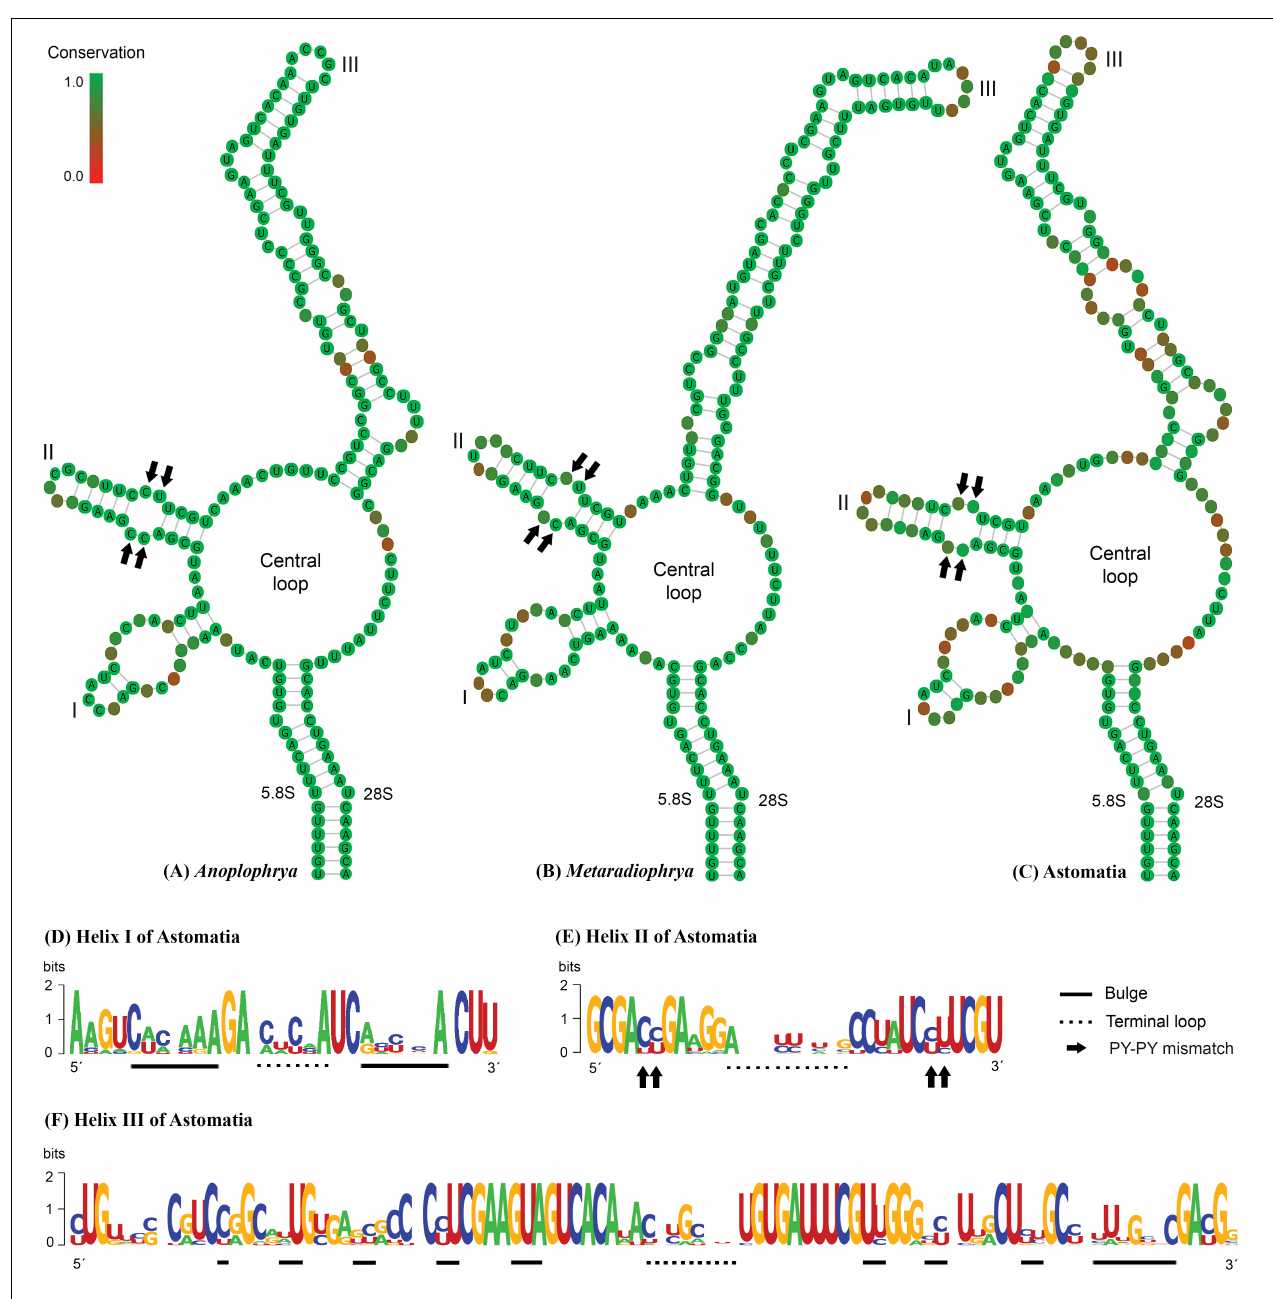
FIGURE 2 | (A–C) Putative consensus secondary structure of the ITS2 molecules of five Anoplophrya species, four Metaradiophrya species, and 15 astome species. (D–F) The structure logos of three helices of 15 astome species. The height of a base is proportional to its frequency in the multiple sequence alignment. For further details, see Table 2 and Supplementary Figures 3–18